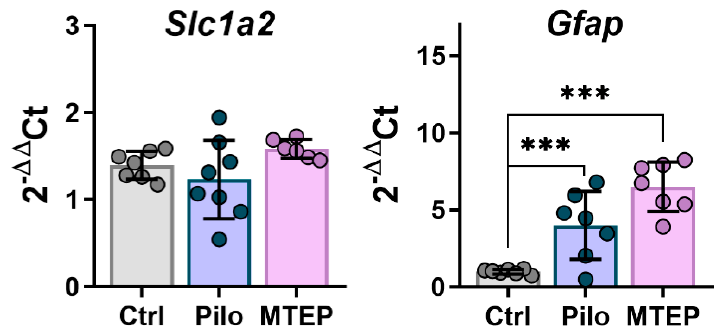
Figure 6. The relative expression of glial markers ( Slc1a2 and Gfap ) in the dorsal hippocampus 7 days after pilocarpine-induced SE. Each dot represents one animal; the bars indicate average values and error bars show standard deviations. One-way ANOVA: Slc1a2: F 2,21 = 1.4, p = 0.3; Gfap: F 2,20 = 21.5, p < 0.001. Asterisks indicate significant differences between groups according to Tukey’s post hoc tests: *** p < 0.001.